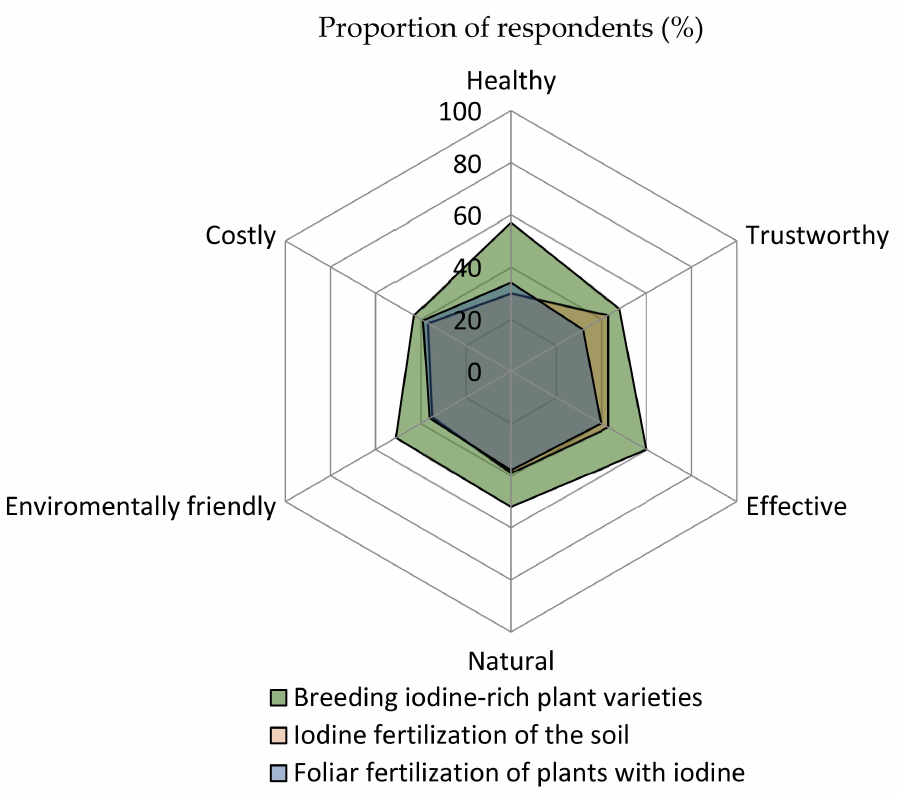
Figure 6. Consumer evaluation of different approaches to increasing iodine content in fruit and vegetables. n =